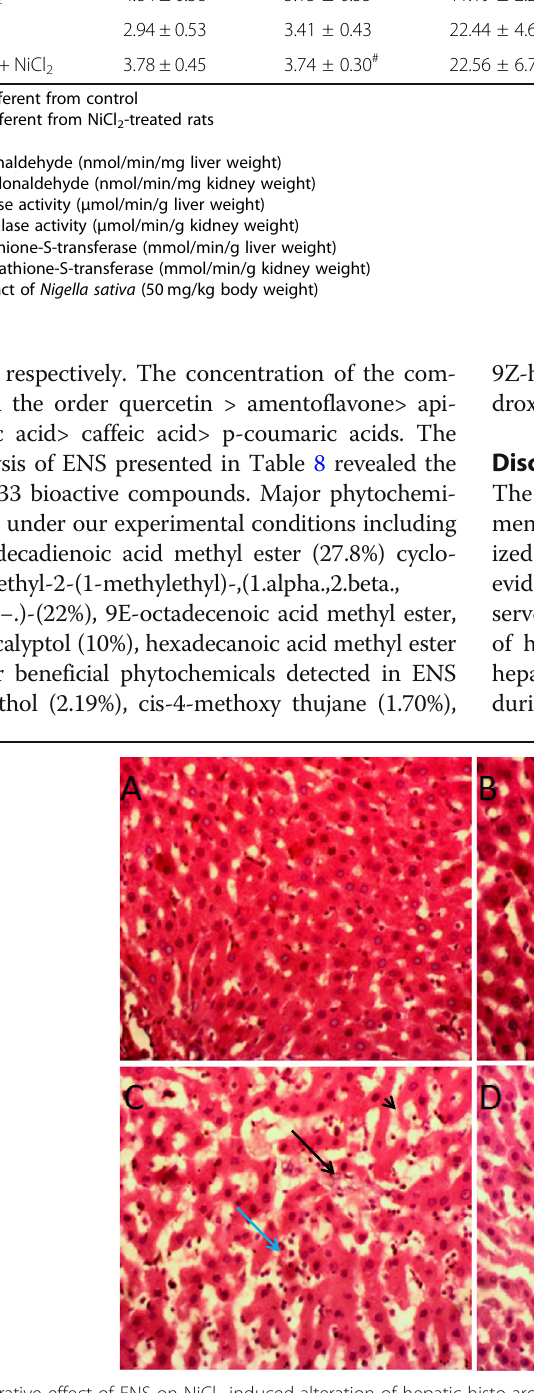
Fig. 1 Ameliorative effect of ENS on NiCl 2 -induced alteration of hepatic histo-architecture in rats. Normal liver histology in the group treated with water and 50 mg/kg ENS alone a and b . Hepatocellular necrosis (black arrow) and atrophy of cord (arrow head) with Kupffer cell hyperplasia (blue arrow) in the group that received NiCl 2 c . Mild atrophy of hepatic cords (arrow head) observed in the group that received a combination of ENS and